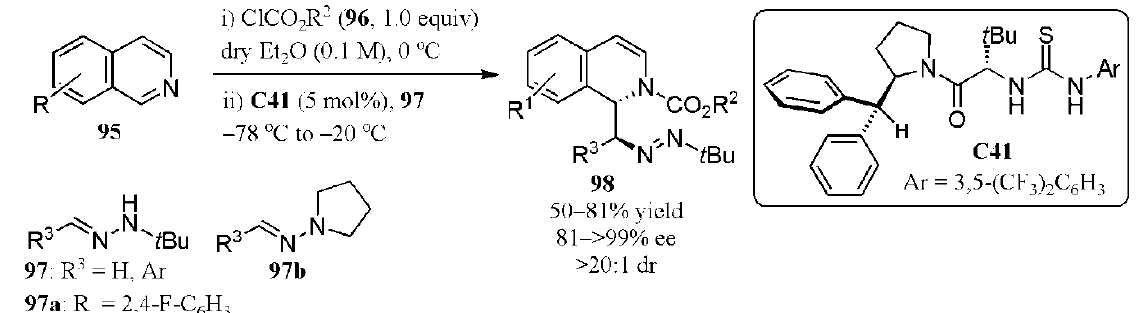
Figure 49. ( a ) The concept of anion binding and the formation of a chiral ion pair in an asymmetric acyl transfer reaction; ( b ) Kinetic resolution of amines by a dual-catalysis anion-binding approach [95].